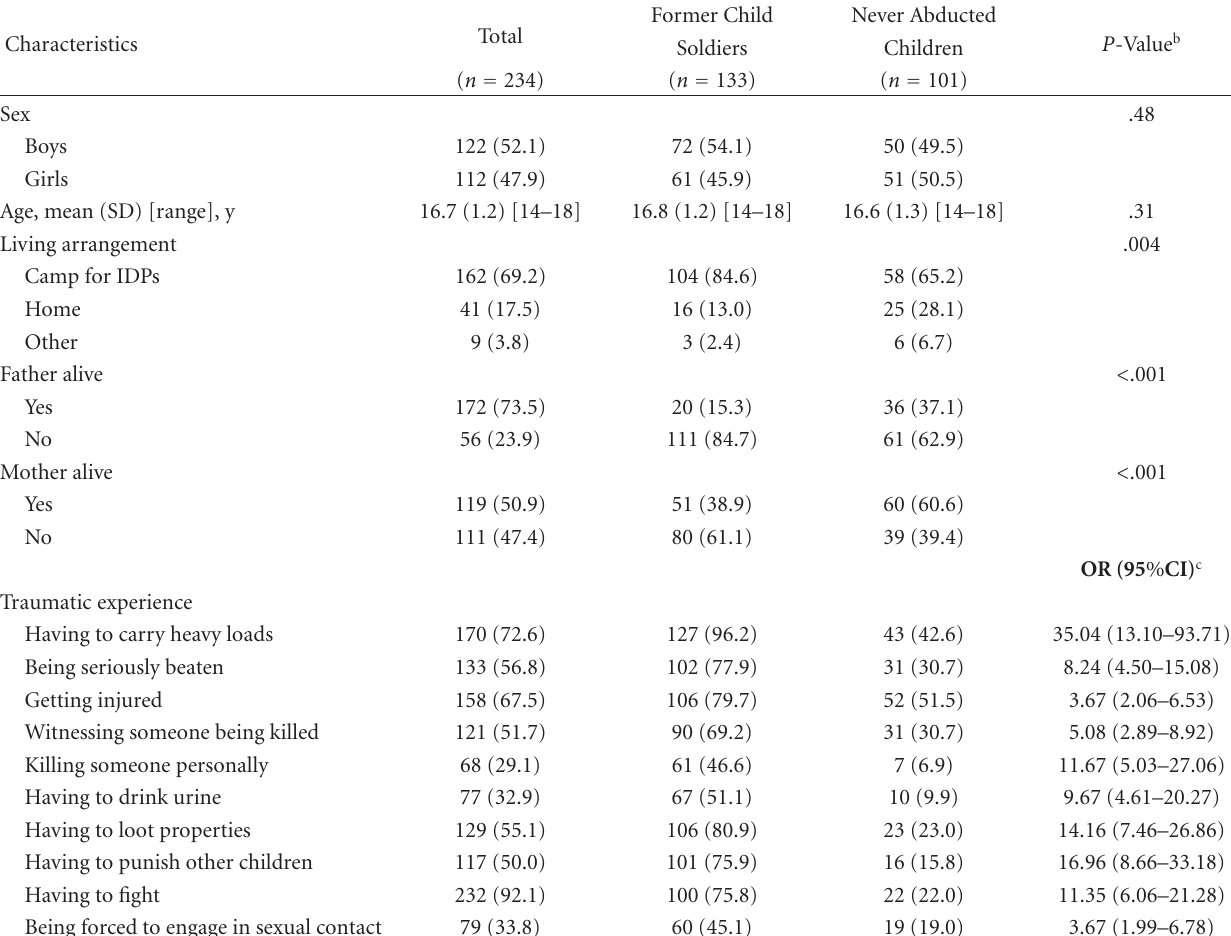
Table 1: Sociodemographic characteristics and war-related traumatic experiences of former child soldiers and children never abducted by the Lord’s Resistance Army a